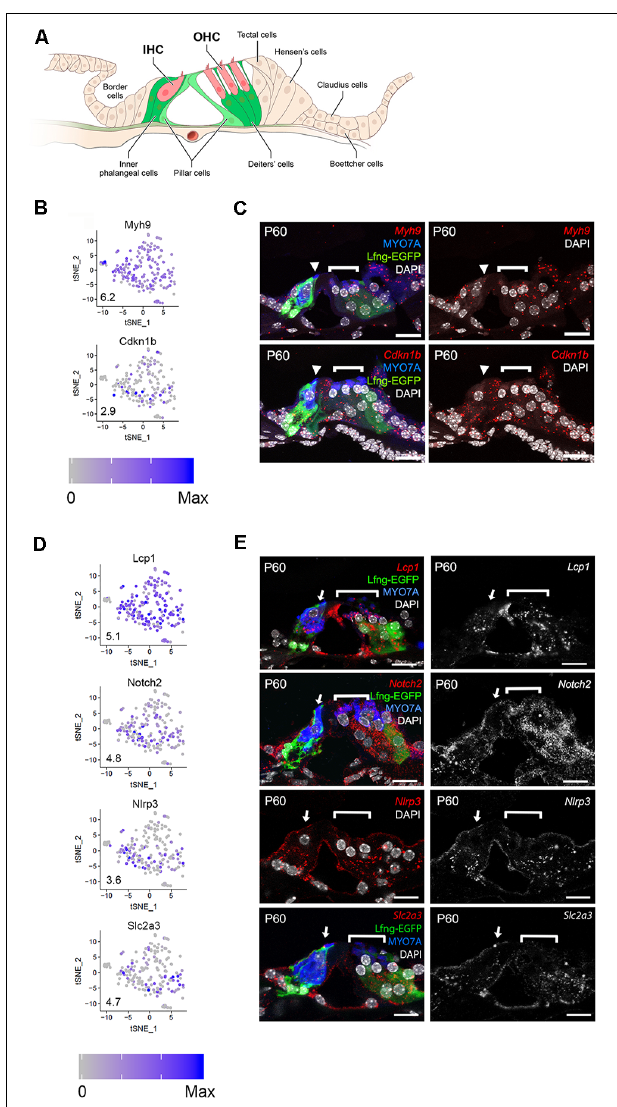
FIGURE 2 | Single-cell RNA-Seq identifies adult SC gene expression. (A) Schematic of adult Lfng EGFP organ of Corti. GFP-expressing cells include inner phalangeal cells, Deiters’ cells, and, to a lesser extent, pillar cells. IHC = inner hair cell, OHC = outer hair cell. Mice that are homozygous and heterozygous for the transgene display the same phenotype. (B) Expression of genes that are known to be expressed by adult cochlear SCs ( Myh9, Cdkn1b ). Feature plots show the expression level of each gene in each cell. An expression is shown in log2 [nTPM] with the maximum expression value (Max) shown in the lower-left corner of each plot. The expression histogram is shown with blue indicating higher expression. (C) smFISH localization of RNA expression for Myh9 , and Cdkn1b in cross-sections of the adult organ of Corti demonstrates localization in all SCs (border, inner phalangeal, the pillar, and Deiters cells). Upper left image demonstrates the Myh9 probe in red along with Lfng-EGFP in green, antibody labeling forMYO7A (HCs), and DAPI-labeling of nuclei. Lower left image shows the Cdkn1b probe in red, Lfng-EGFP in green, MYO7A (HCs), and DAPI-labeling of nuclei. Upper and lower panels to the right illustrates the smFISH channel with DAPI-labeling of nuclei. (D) Expression of previously uncharacterized adult cochlear SC genes ( Lcp1, Notch2 , Nlrp3 , Slc2a3 ) presented as in panel (B) . (E) smFISH localization of RNA expression for Lcp1, Notch2 , Nlrp3 , and Slc2a3 in